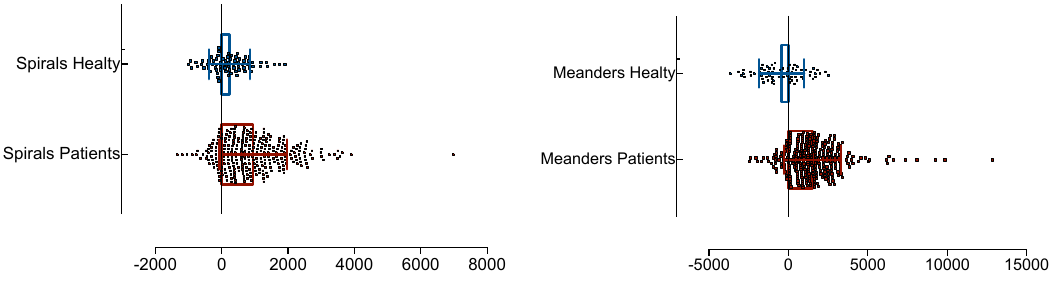
Figure 4. Scatter plot of the best rule condition, rearranged as ( 2 ∗ x 0 + x 5 − x 7 − ( x 1 + x 4 + 2 ∗ x 6 )) ≤ 0, applied to the whole dataset. Bars represent the average and standard deviation.